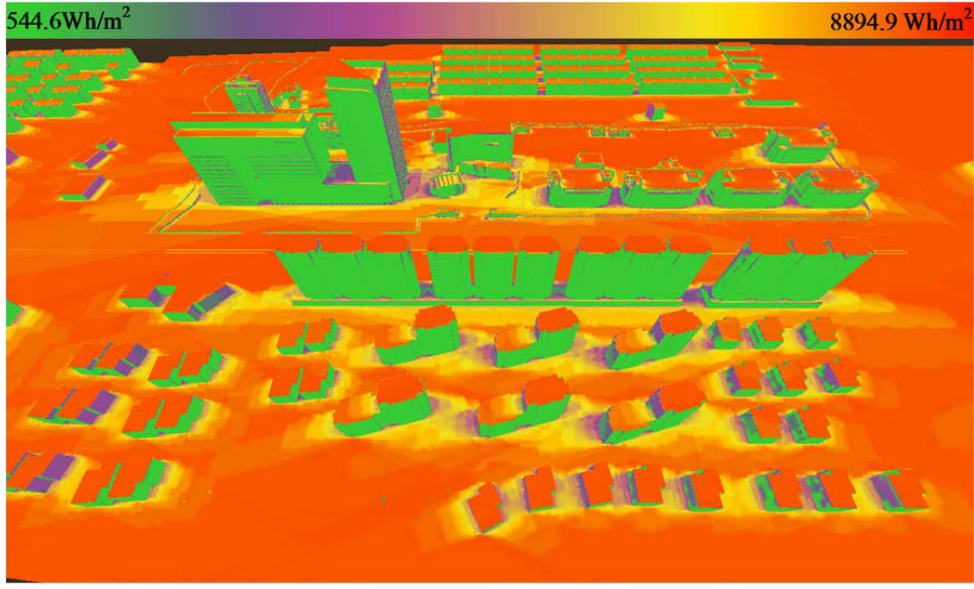
Figure 15. Daily clear sky global irradiation for 23 July.